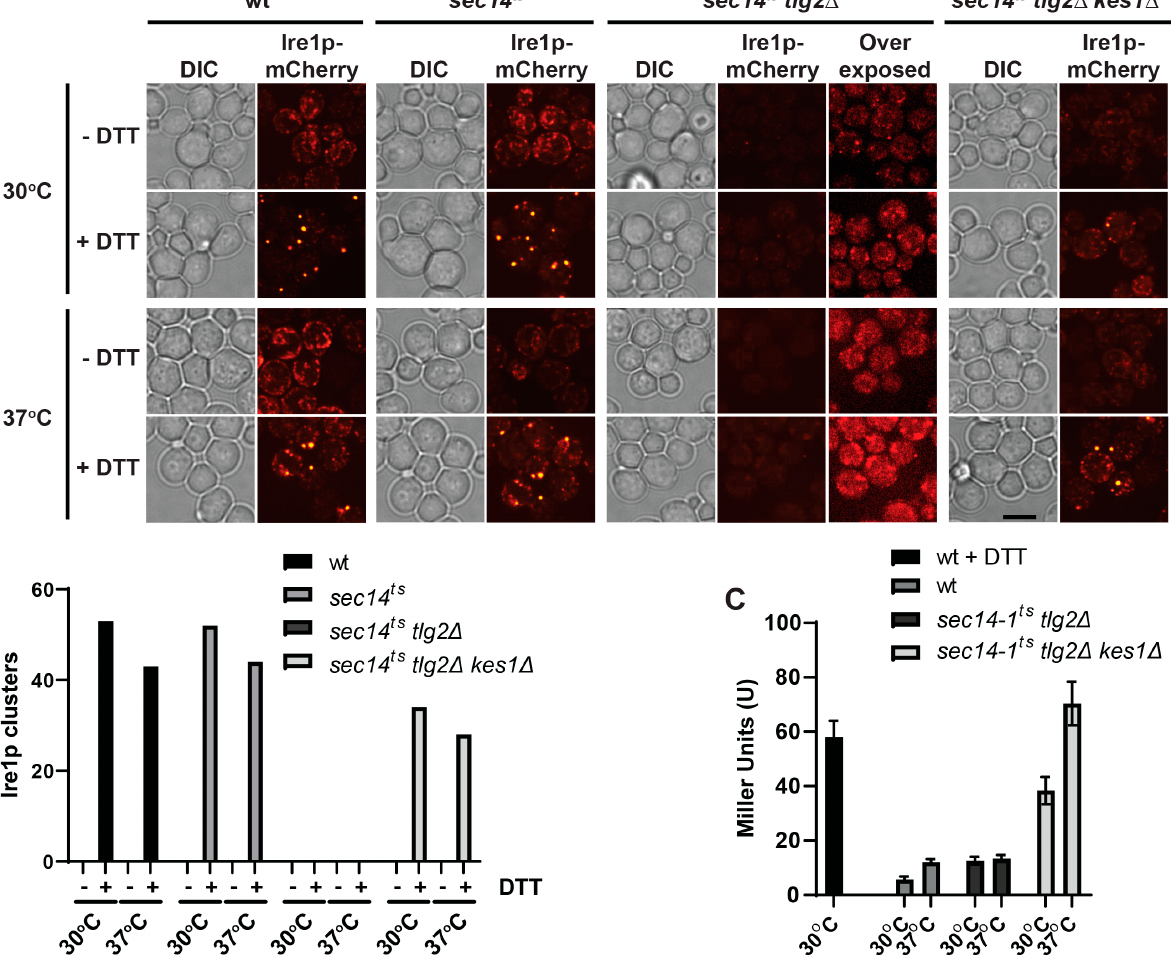
Figure 1. Kes1p hyperactivity attenuates UPR activity by attenuating Ire1 clustering. ( A ) Fluorescence microscopy images taken from wt (CTY182) sec14 ts (CTY5-2), sec14 ts tlg2 Δ (CTY1920), and sec14 ts tlg2 Δ kes1 Δ (CTY1958) expressing Ire1-mCherry. Cells were cultured at 30 °C and 37 °C for 2 h, followed by treatment with ±10 mM DTT. Over-exposed images of CTY1920 are shown to address low signal intensity. ( B ) Cell counts determining the proportions of cells containing high-intensity Ire1-mCherry clusters, taken from microscopy images described above. At least 150 cells were counted for each condition. ( C ) Wt (CTY182), sec14 ts tlg2 Δ (CTY1920), and sec14 ts tlg2 Δ kes1 Δ (CTY1958) cells transformed with pJT30 (UPRE-LacZ) were grown in –Ura selective medium and β -Galactosidase activity determined. As a positive control, wild-type cells were treated with 5 mM DTT for 2 h.